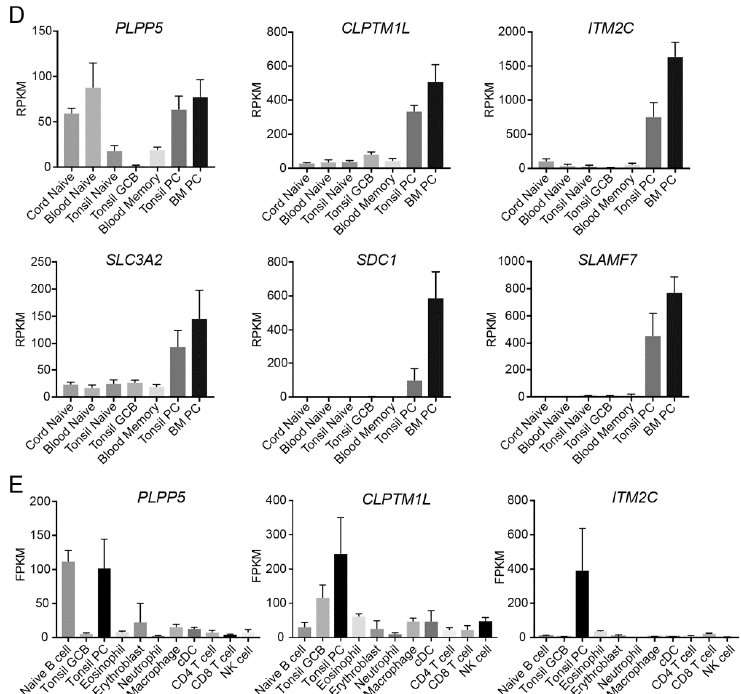
Figure 2. Expression of the human homologues in ASCs. Alignment of mouse and human amino acid sequences for ( A ) PLPP5, ( B ) ITM2C, and ( C ) CLPTM1L. Symbols indicate conserved (I), highly similar (:), and similar (.) residues. ( D ) RNAseq showing the expression of PLPP5 , CLPTM1L , ITM2C and three established clinical candidates SLC3A2 , SDC1 and SLAMF7 in purified human B cell and ASC populations. Data are the mean reads per kilobase per million reads (RPKM) ± SD from 3–5 donors each. Cord naïve B cell (CD19 + CD20 + HLA-DR + IgG − ), blood naïve B cell (CD19 + IgD + CD27 − ), tonsil naïve B cell (CD19 + CD38 − CD27 − ), tonsil germinal center (GCB) B cell (CD19 + CD38 + CD27 + ), blood memory B cell (CD19 + IgD − CD27 + CD38 − /low ), tonsil plasma cell/plasmablast (PC, CD19 + CD27 ++ CD38 ++ ), bone marrow plasma cell (BM PC, CD138 ++ CD38 + ). ( E ) RNAseq showing the expression of PLPP5 , CLPTM1L and ITM2C in human immune cell populations. Data obtained from the BLUEPRINT consortium (www.blueprint-epigenome.eu). Data are the mean fragments per kilobase per million reads (FPKM) ± SD. Blood naïve B cell ( n = 5, CD19 + CD20 + CD23 + CD38 low ), tonsil GCB cell ( n = 3, CD19 + CD20 + CD38 medium ), tonsil PC ( n = 21, CD20 medium CD38 ++ ), blood eosinophil ( n = 2, CD66 + CD16 − ), blood erythroblast ( n = 8, CD36 + CD71 + CD235a + ), blood neutrophil ( n = 16, CD66b + CD16 + ), cultured macrophages ( n = 18) and conventional dendritic cell cDC ( n = 3), blood CD4 + T cell ( n = 10, CD3 + CD4 + CD45RA + ), blood CD8 + T cell ( n = 2, CD3 + CD8 + CD45RA + ), blood natural killer (NK) cell ( n = 4, CD3 − CD56 + CD16 dim